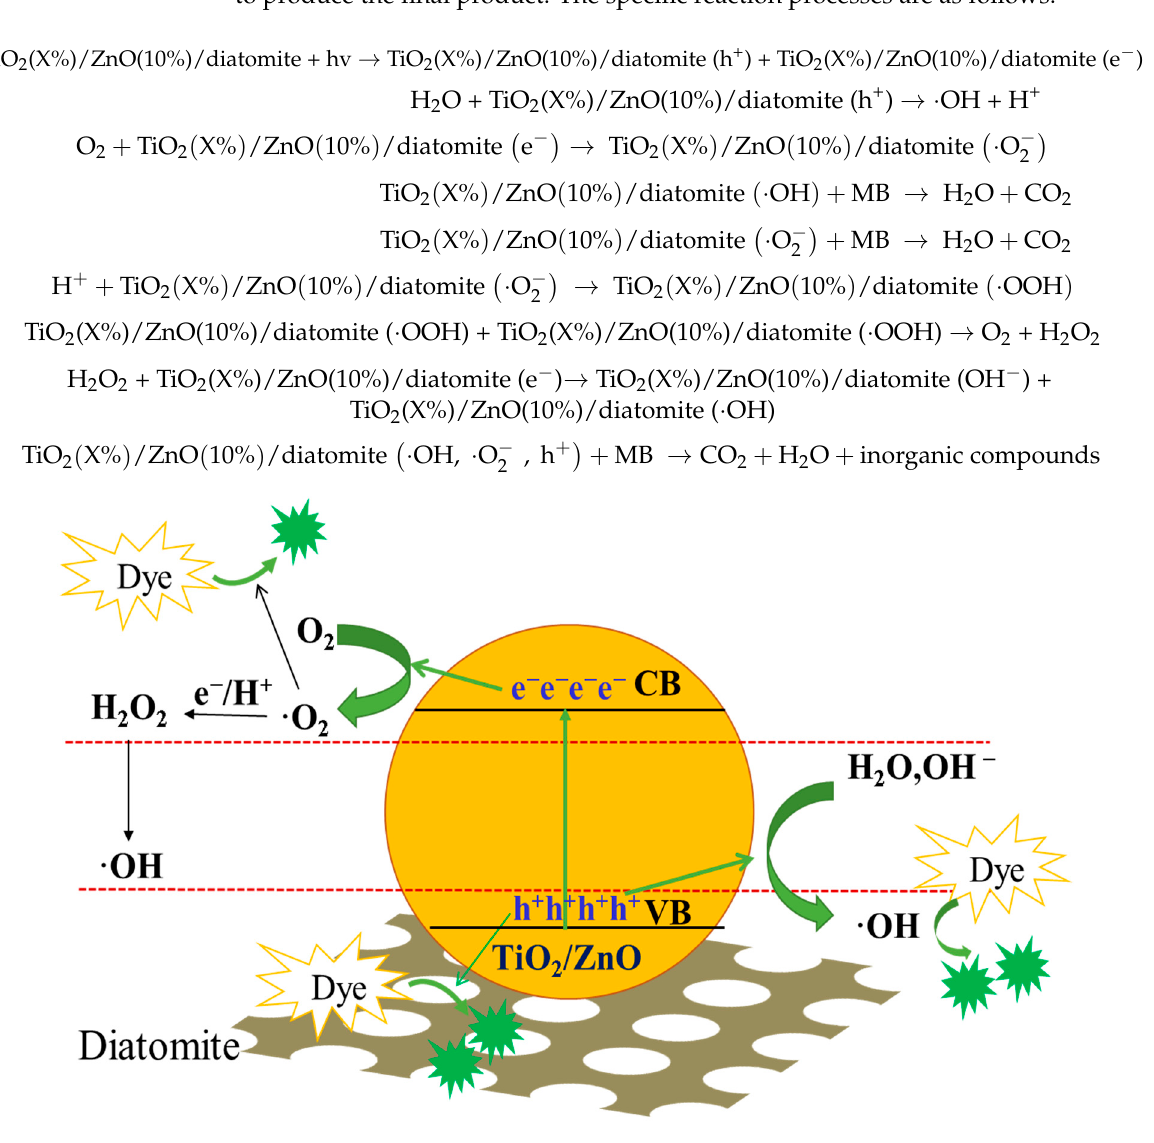
Figure 15. Schematic of the photocatalytic degradation mechanism of TiO 2 (X%)/ZnO(10%)/diatomite.